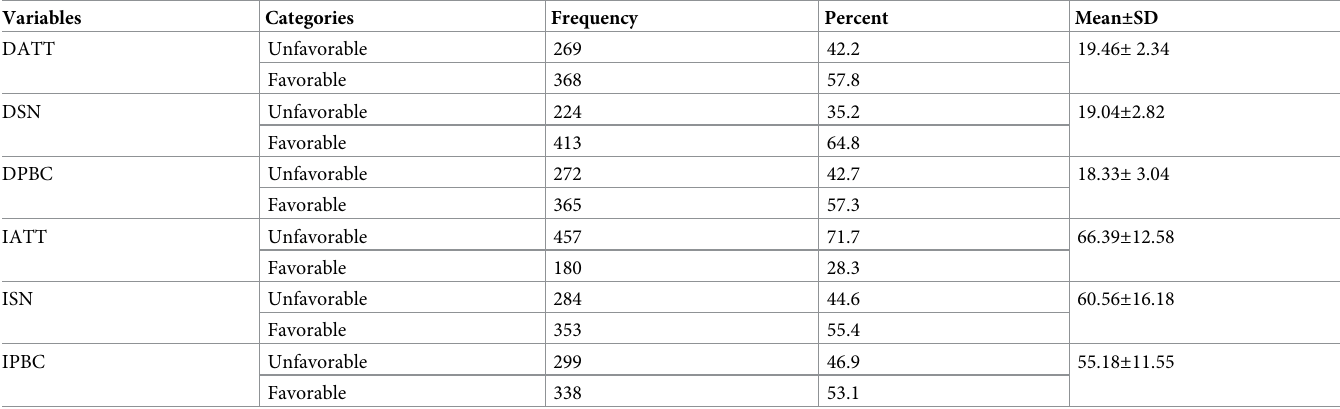
Table 3. Components of TPB among pregnant women in Yilmana Densa district, 2020.